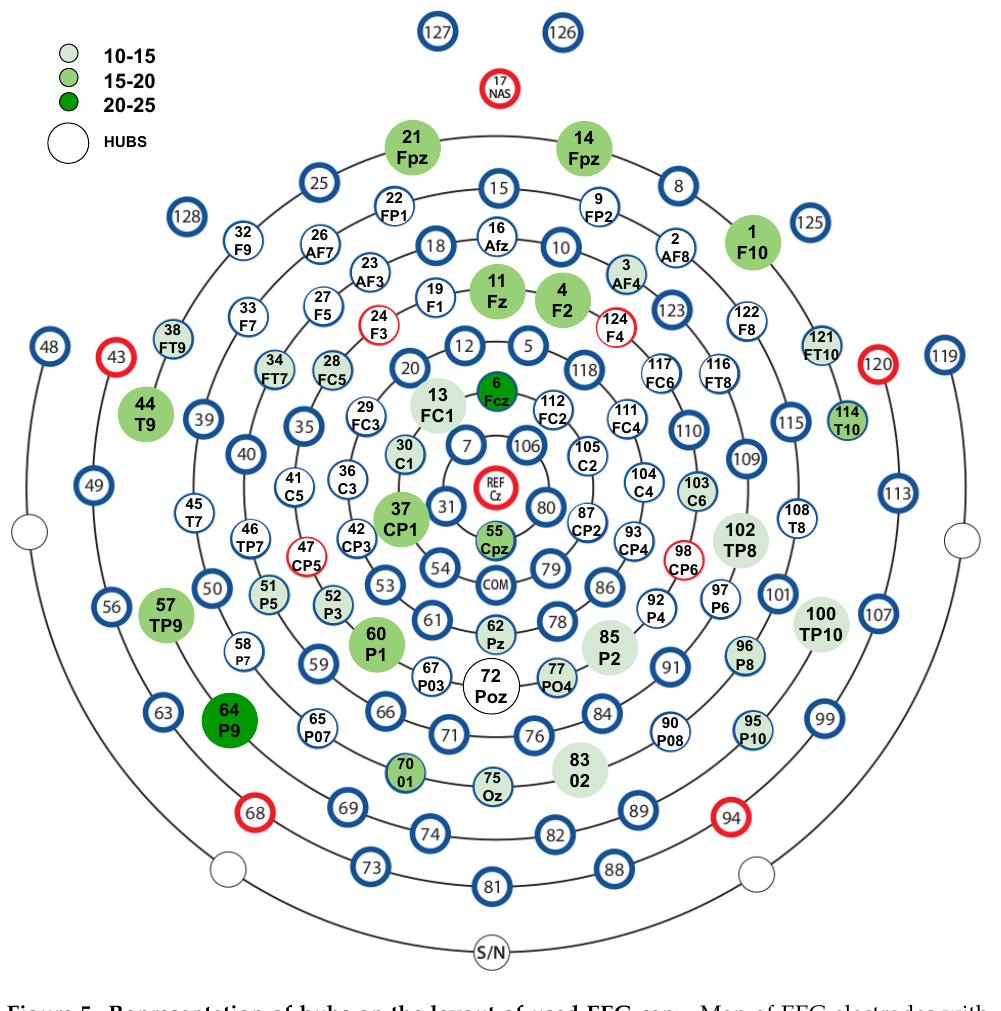
Figure 5. Representation of hubs on the layout of used EEG cap: Map of EEG electrodes with color code according to the number of times the node is active in the network across emotion groups. The electrodes with a large size are calculated as hubs using eigenvector centrality with less than 5% chance of being falsely detected as hubs (permutation test with 10,000 Erdos-ranyi random models). See Figures S2 and S3 & Table S1 . Abbr. are– Fc: fronto-central, Fp: Frontopolar, Af: Anterior